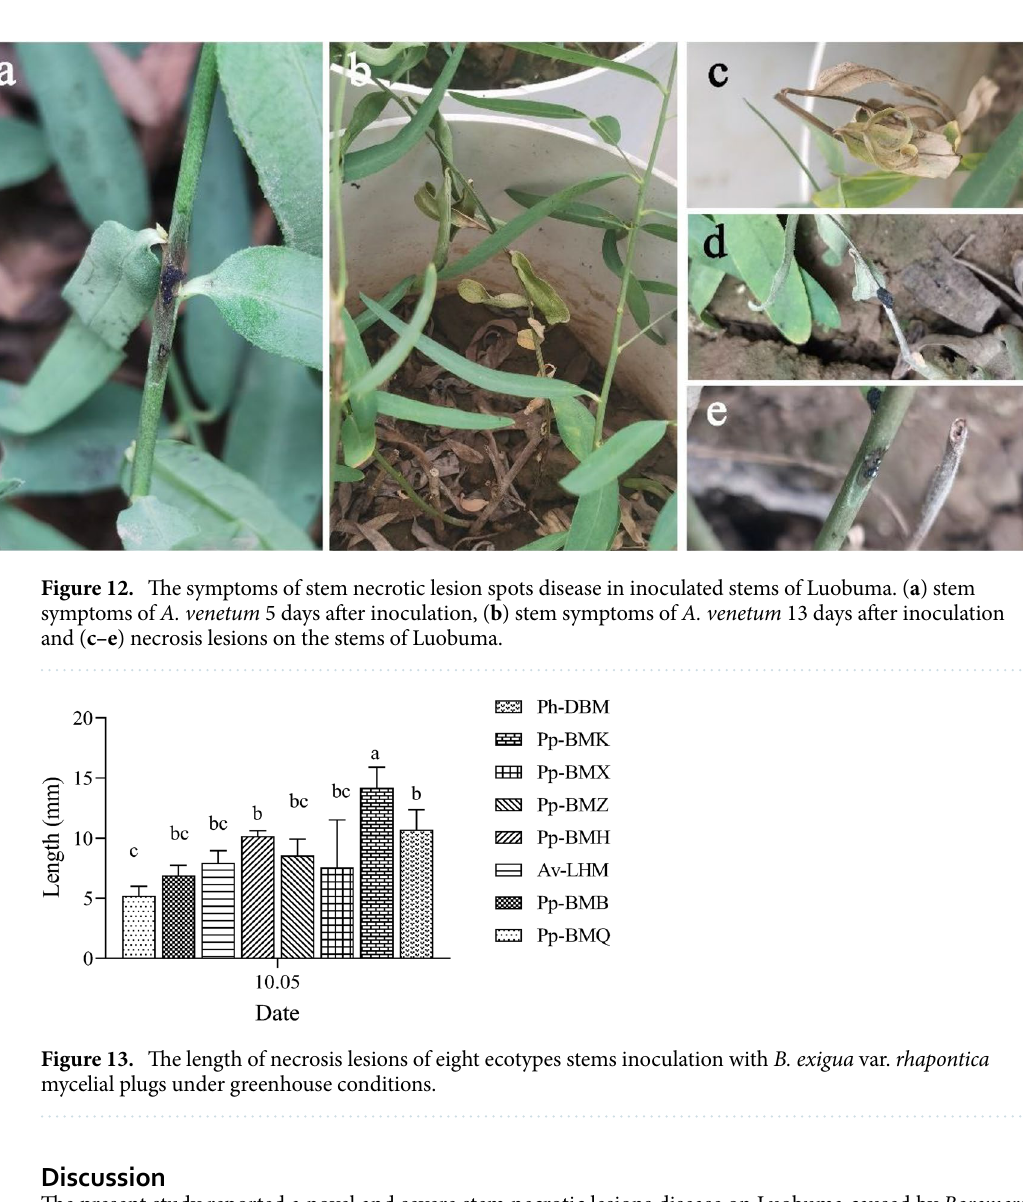
Figure 11. The disease incidence of eight ecotypes leaves inoculation with B. exigua var. rhapontica conidial suspensions under greenhouse conditions.